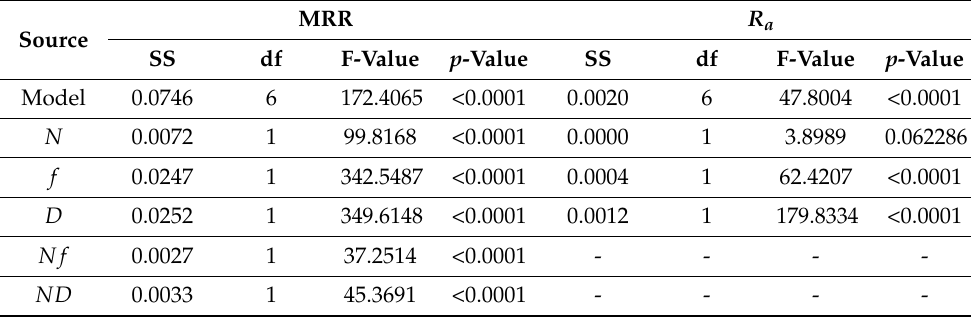
Table 2. ANOVA for the robust mathematical